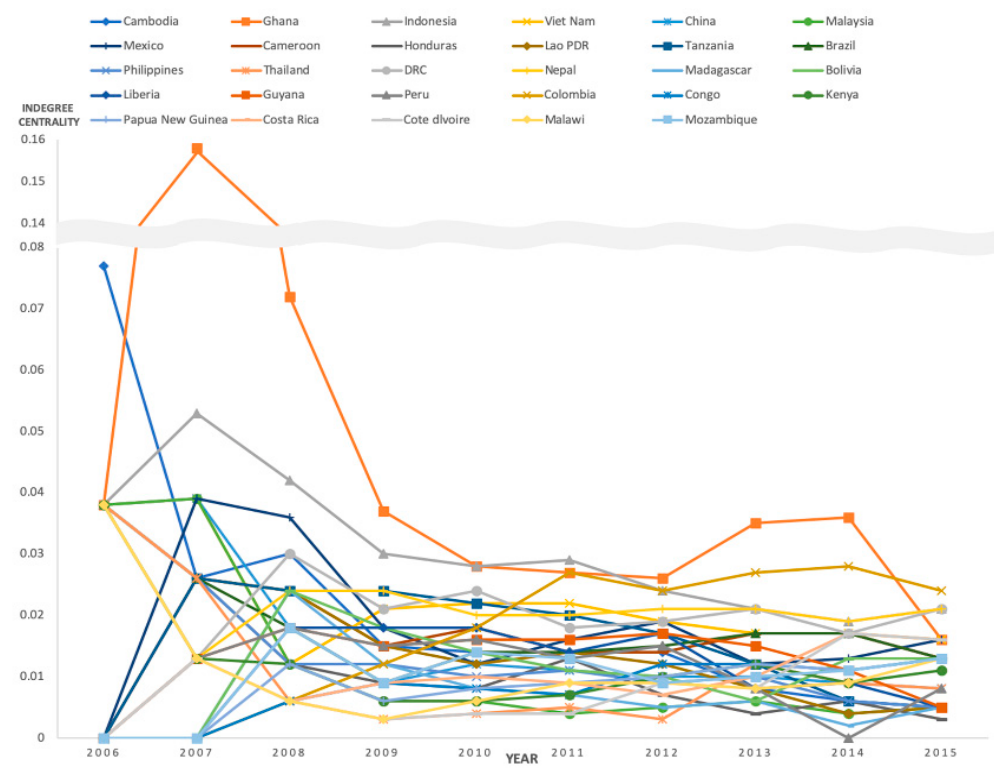
Figure 9. Annual changes in in-degree centrality of major recipients between 2006 and 2015 (y-axis break between 0.08 and 0.14 was applied to improve visualization). (Lao PDR: Lao People’s Democratic Republic, DRC: Democratic Republic of the Congo).